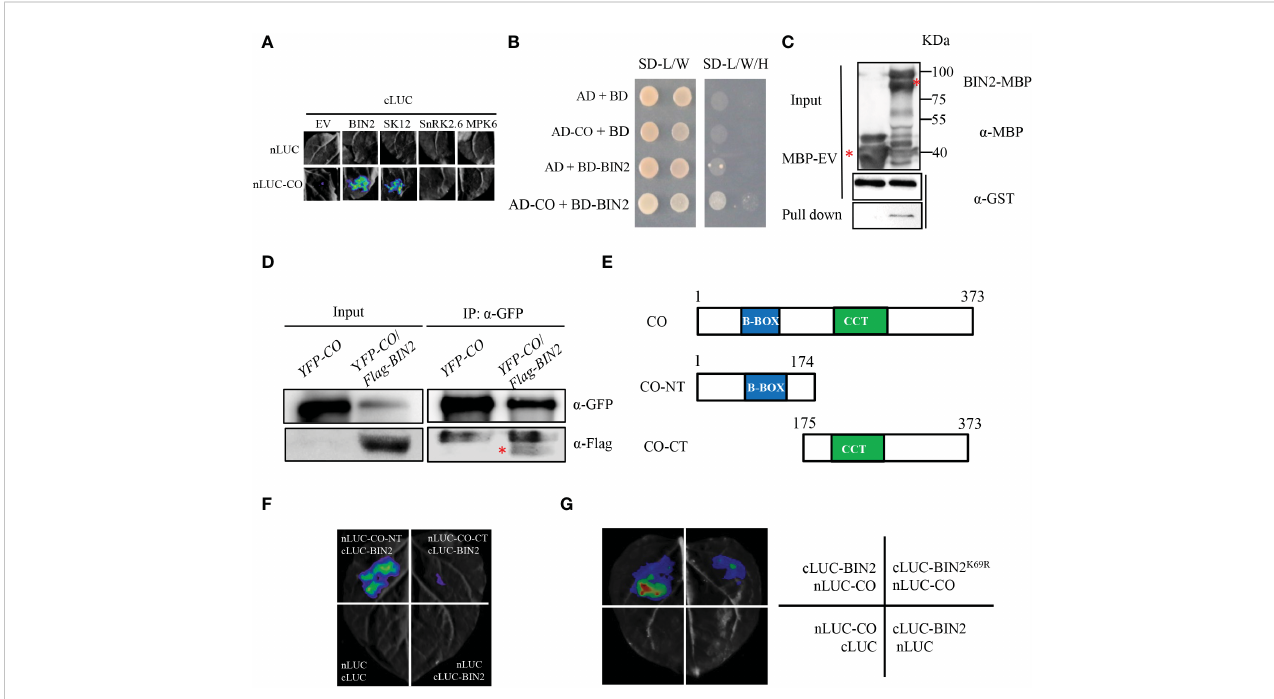
FIGURE 1 BIN2 physically interacts with CO in vitro and in vivo . (A) Identi fi cation of CO ‐ interacting protein kinases. Luciferase complementation imaging (LCI) assays showing the interactions between CO and protein kinases in N. benthamiana leaves. Representative images of N. benthamiana leaves after in fi ltration were shown. Empty vectors were used as negative controls. (B) Y2H assay showing the interaction between BIN2 and CO. SD-L/W, synthetic dextrose medium lacking Leu and Trp; SD-L/W/H, synthetic dextrose medium lacking Leu, Trp and His. (C) In vitro pull-down assay showing that BIN2 directly interacts with CO. Puri fi ed GST-CO proteins were incubated with MBP or MBP-BIN2 for the MBP pull-down assay. Red asterisk indicates speci fi c bands. (D) Co-IP assays showing the interaction between BIN2 and CO in Arabidopsis . The 35S:YFP-CO and 35S:YFP-CO/35S:Flag-BIN2 transgenic plants were grown for 10 days under LDs. Red asterisk indicates speci fi c signal. The immunoprecipitates were detected using anti-GFP and anti-Flag antibodies, respectively. (E) Schemes displaying full-length and truncated versions of the CO protein. CO-NT, amino terminal domain of CO; CO-CT, carboxyl terminal domain of CO. (F) LCI assay showing the interaction between the truncated versions of CO and full-length BIN2 in N. benthamiana leaves. (G) LCI assay showing less LUC activities between BIN2 K69R and